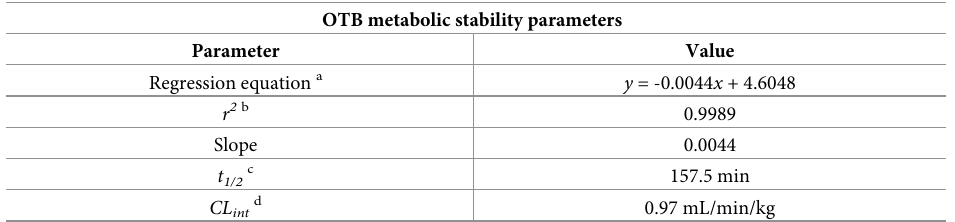
a Regression equation of linear portion of curve b Correlation coefficient c